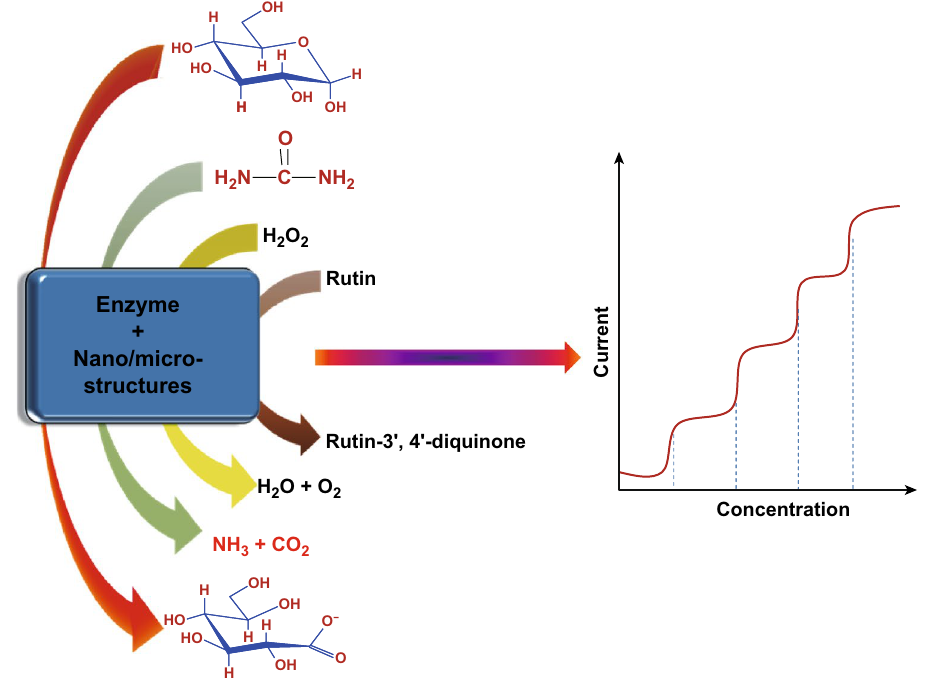
Fig. 2 Proposed biosensing mechanism of